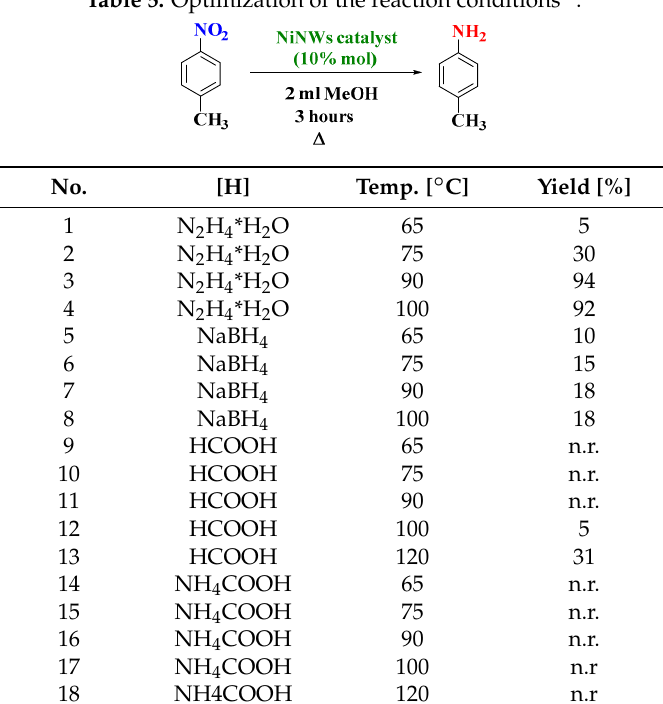
Table 5. Optimization of the reaction conditions a .